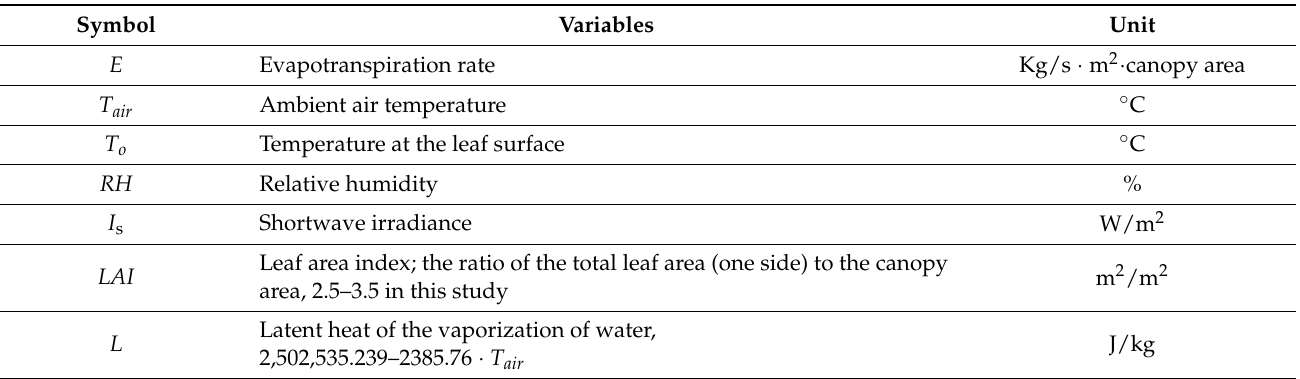
Table 2. Symbol and unit for the various variables used to calculate the evapotranspiration rate of the Stanghellini model